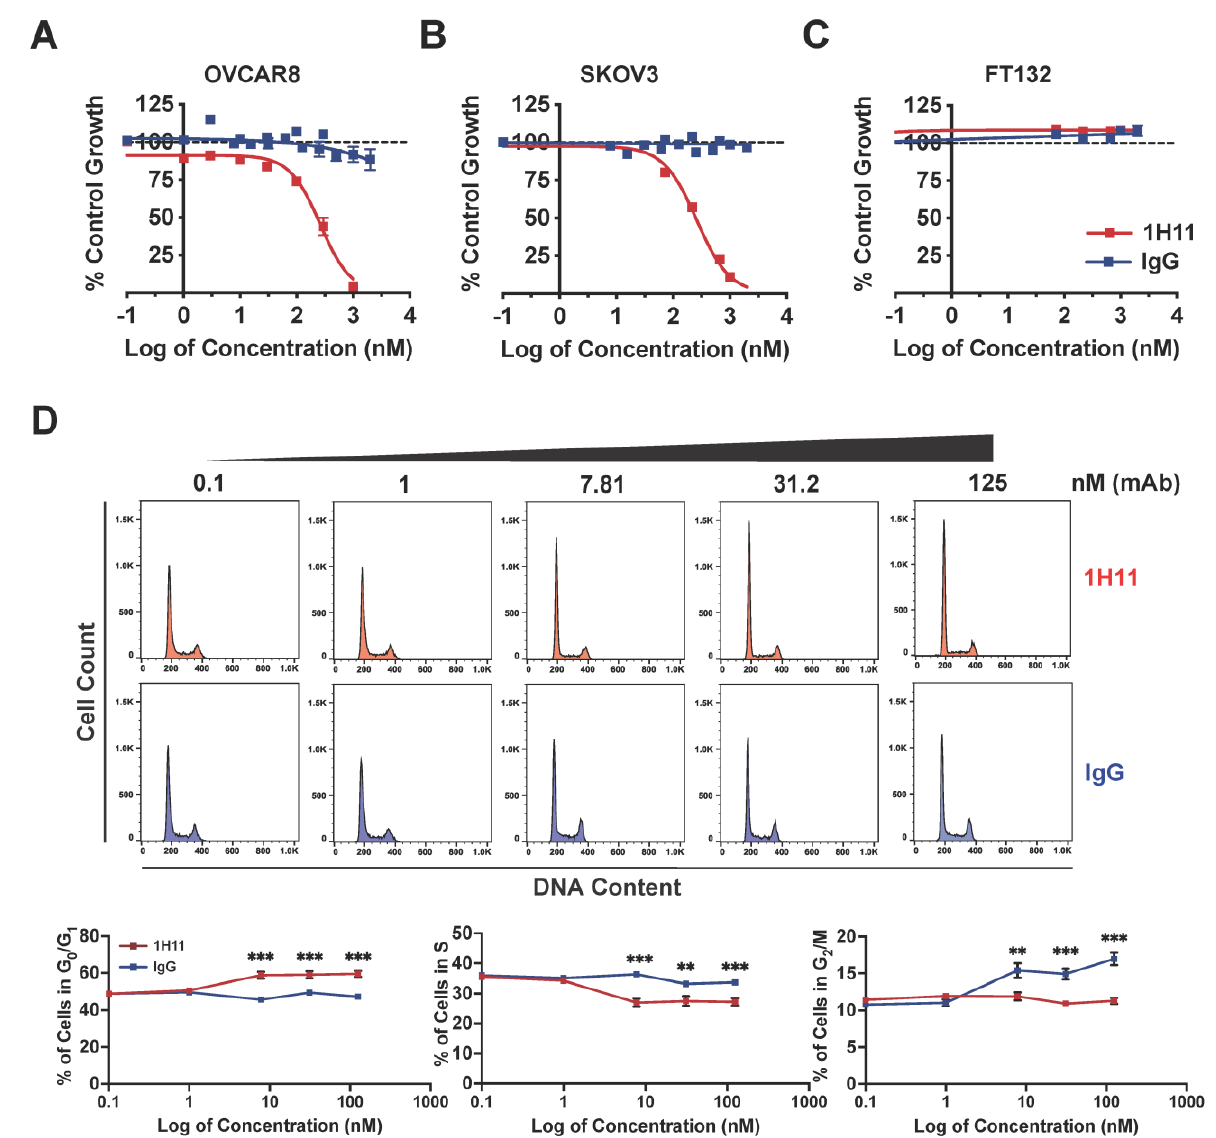
Figure 3. 1H11 induces OC cell cytotoxicity and cell cycle arrest. ( A – C ) Evaluated by SRB assay, 1H11 selectively inhibited OC cell proliferation with an EC 50 of 260 nM in both ( A ) OVACR8 and ( B ) SKOV3 with no cytotoxic effects on ( C ) FT132. ( D ) Cell-cycle analysis of OVCAR8 cells treated for 72 h was performed by flow cytometry. Significant G0/G1 cell-cycle arrest was induced in a dose-dependent manner by 1H11. All data plotted as mean ± SEM. *** p < 0.001, ** p < 0.01 vs. IgG.